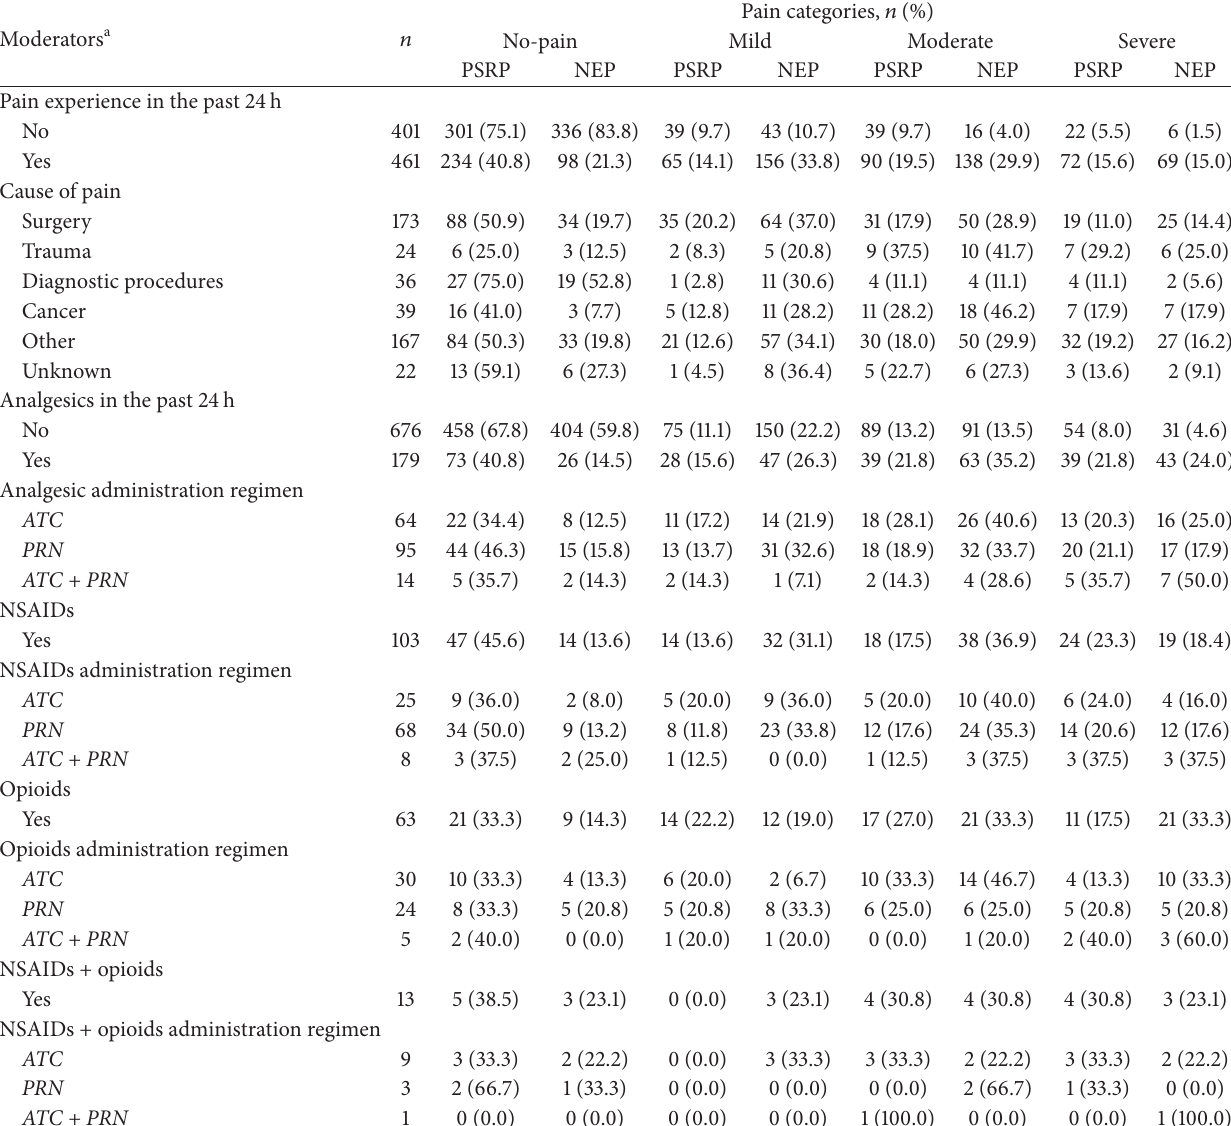
Table 2: Distribution and proportions of NEP and PSRP pain categories in the